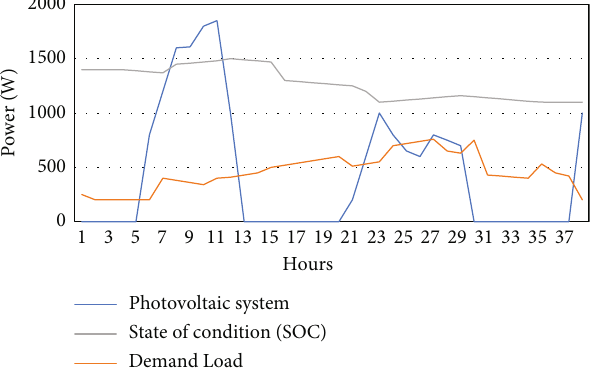
Figure 12: Three days in the month of